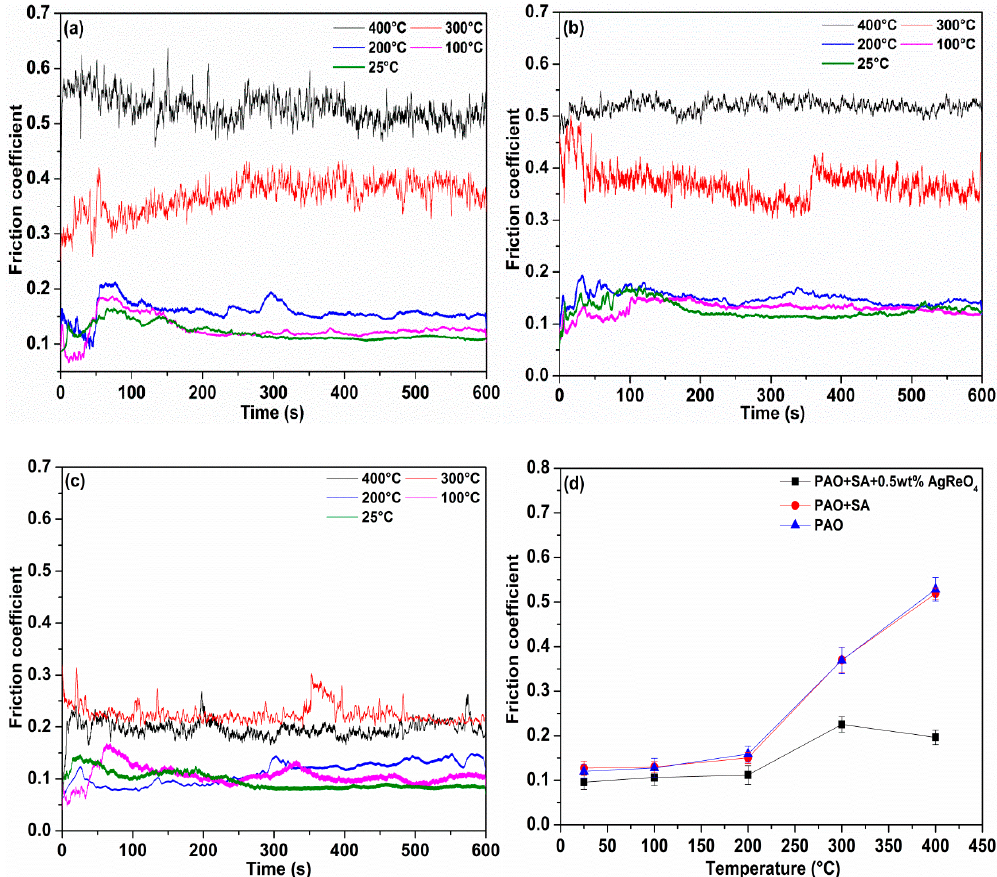
Figure 8. The friction coefficient curves and average friction coefficient value of worn surface lubricated by different oil mixtures at varying temperatures. ( a ) PAO; ( b ) PAO + SA; ( c ) PAO + SA + 0.5 wt% AgReO 4 ; ( d ) average friction coefficient value.